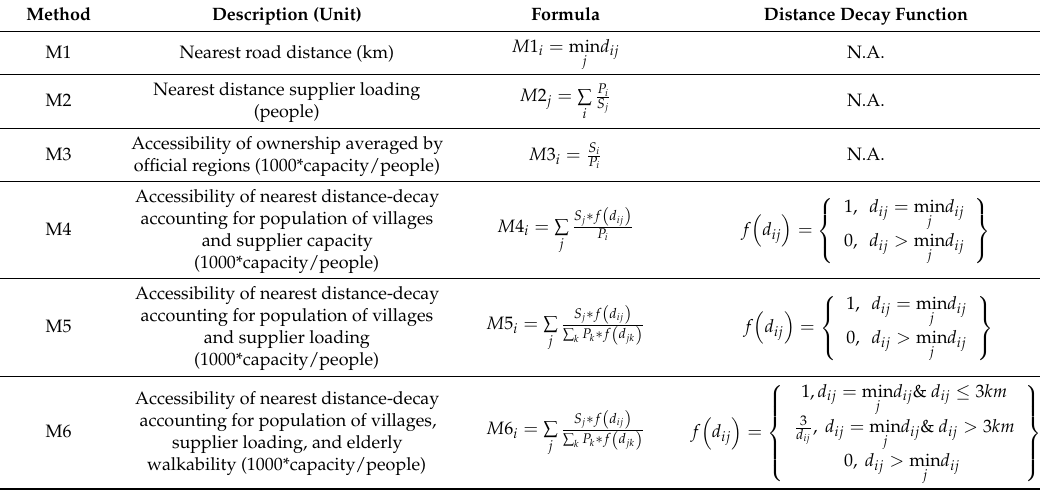
Table 1. Definition of spatial accessibility